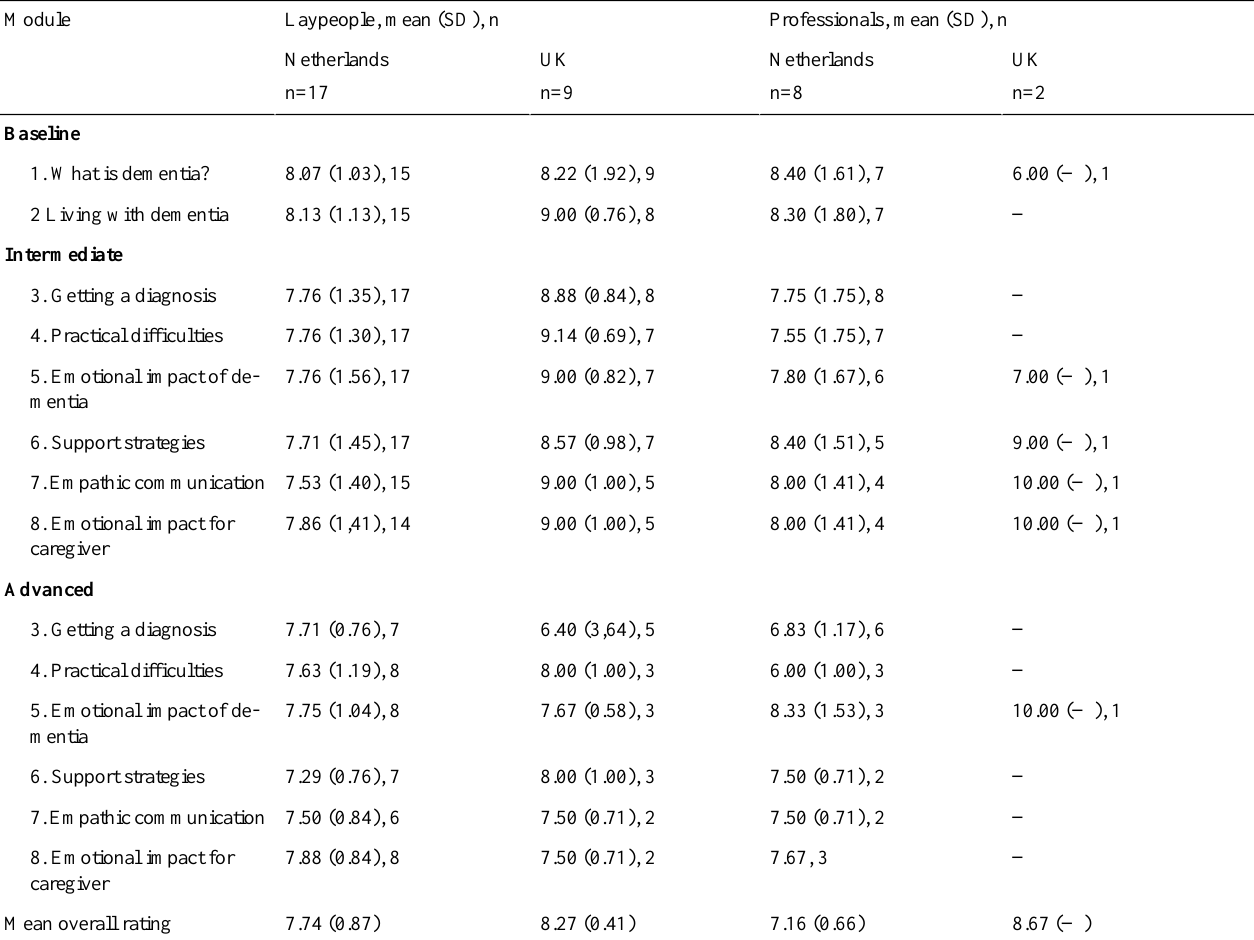
Table 2. Rating of usefulness of the modules by the participants at post-test (mean score on scale 1-10). a